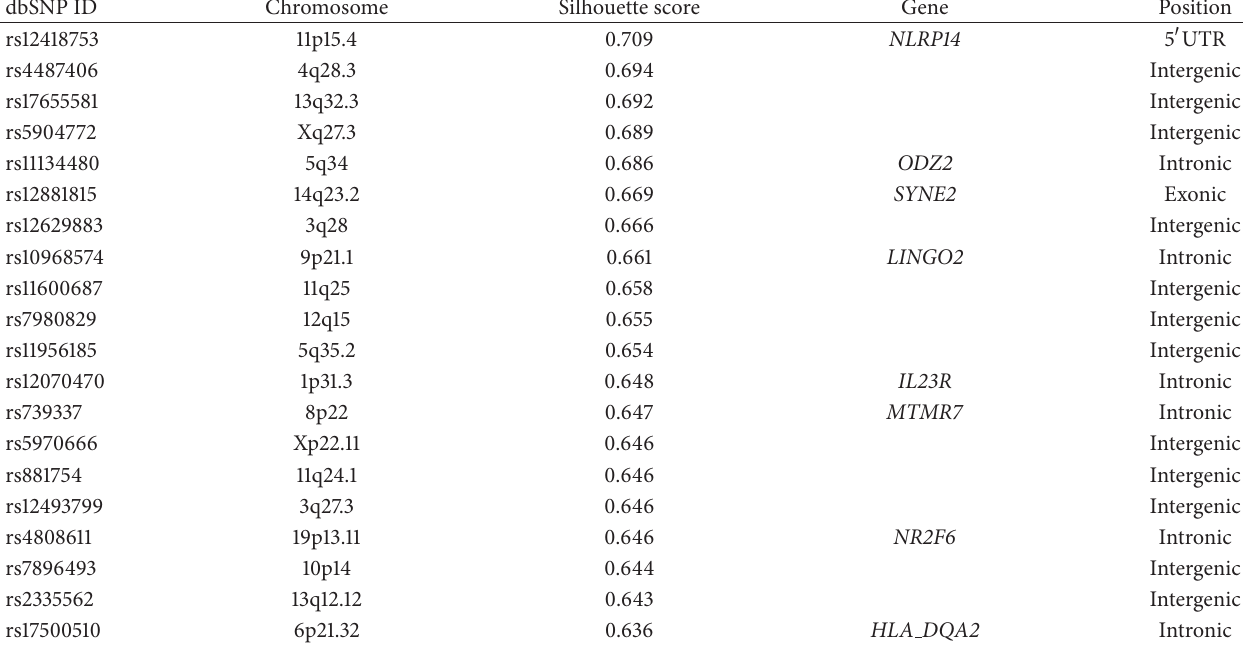
Table 2: The top 20 ranked SNPs in the pooled GWAS.